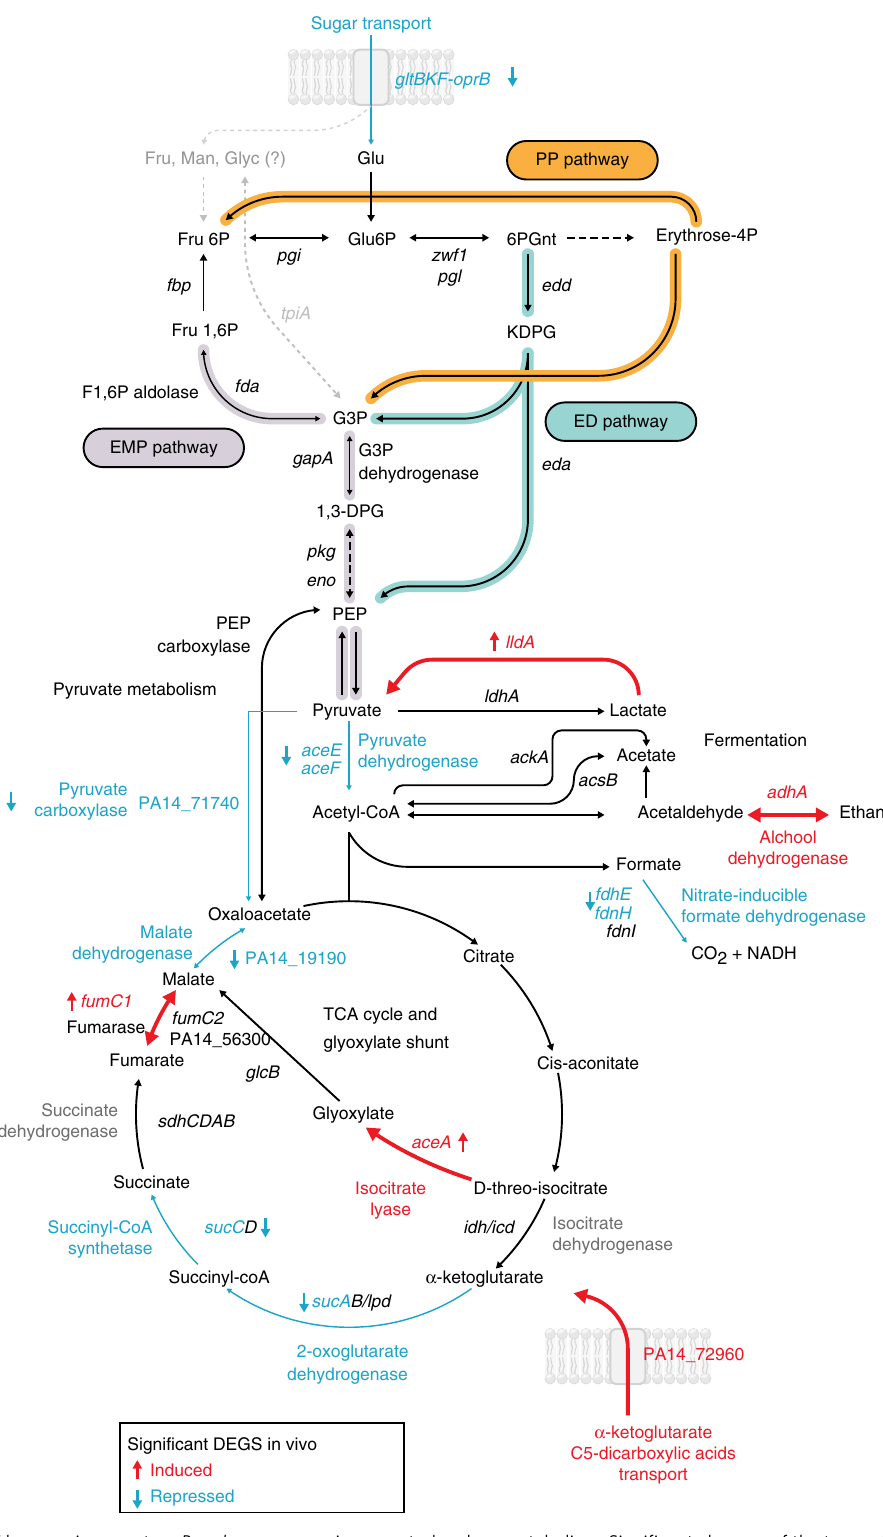
Fig. 4 Effects of the CF lung environment on Pseudomonas aeruginosa central carbon metabolism. Signi fi cant changes of the transcriptomic pattern between the in vitro- and in vivo-grown bacteria are reported. Transcripts, encoded enzymes, and catalyzed reaction (arrows) enriched during growth in CF lung are given in red, and decreased transcripts are indicated in blue. Genes and reactions not statistically signi fi cant are reported in black. Dashed lines connecting metabolic intermediates indicate that the reaction is carried out by multiple consecutive enzymes not